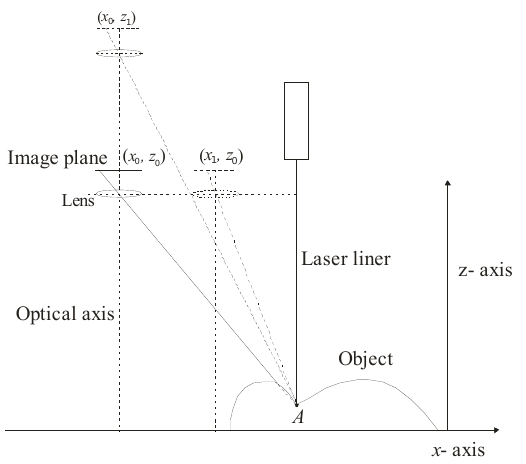
Figure 11. Geometry of an occlusion in the initial